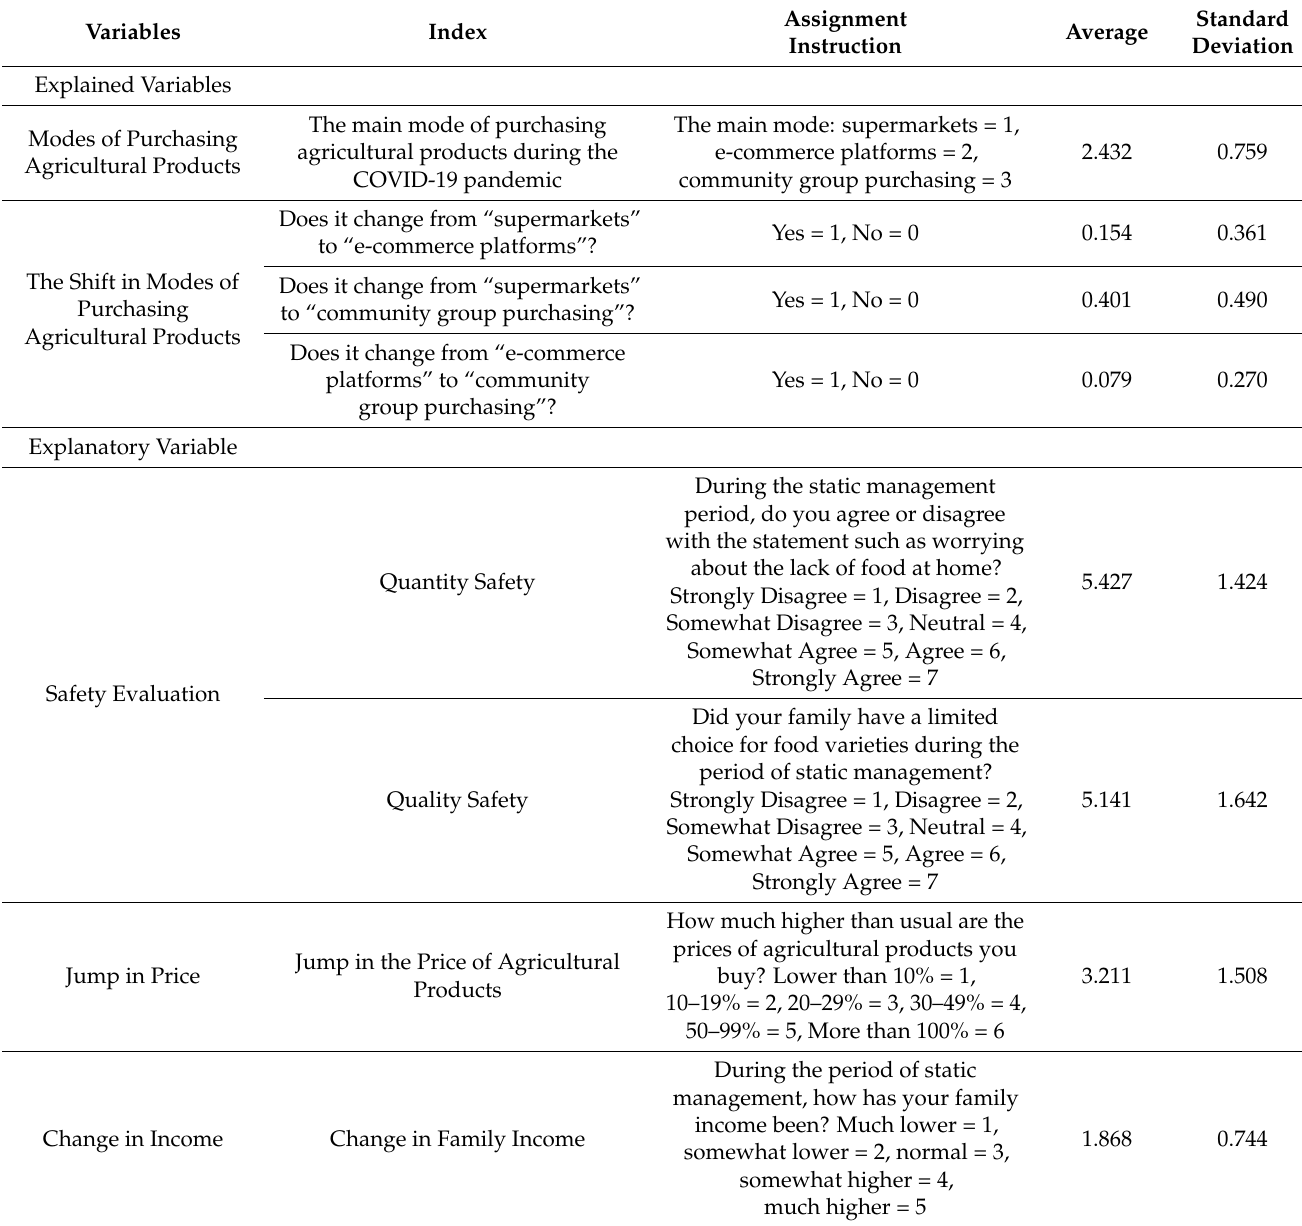
Table 1. Setting and meaning of variables in MProbit and Probit